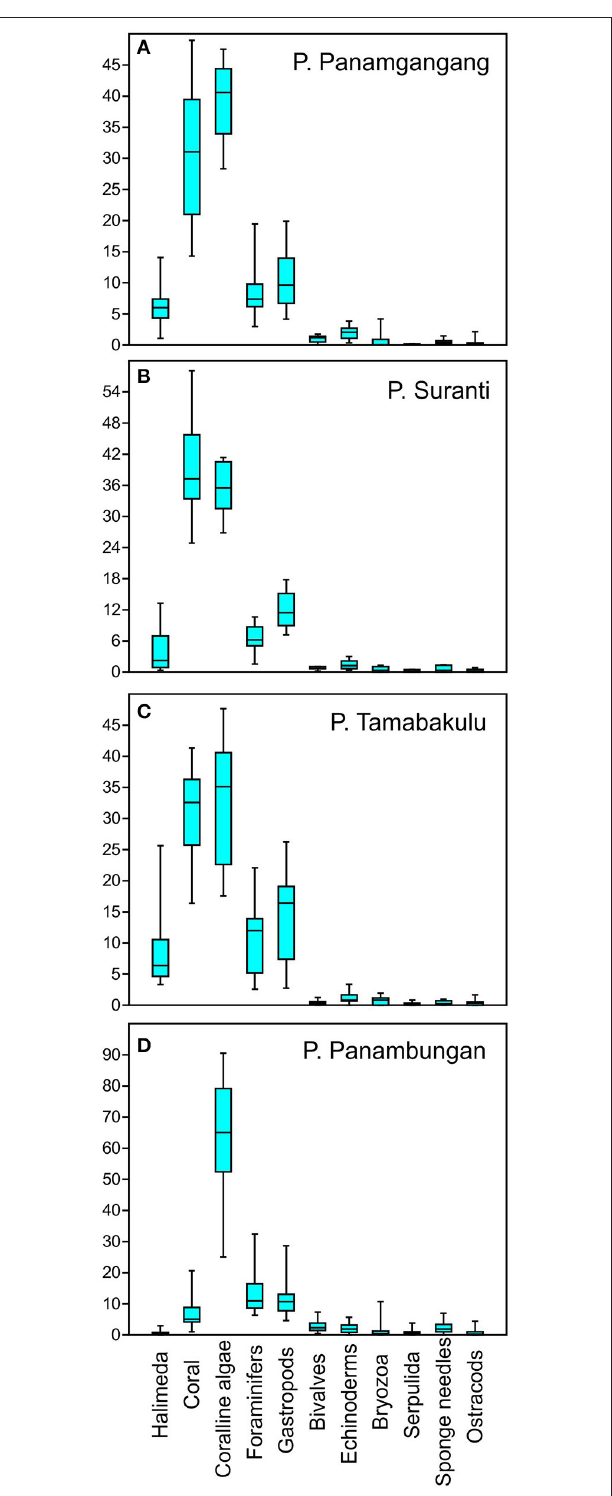
FIGURE 5 | Box- and Whisker plots indicating the mean percentage distribution of surface sediment components from the four